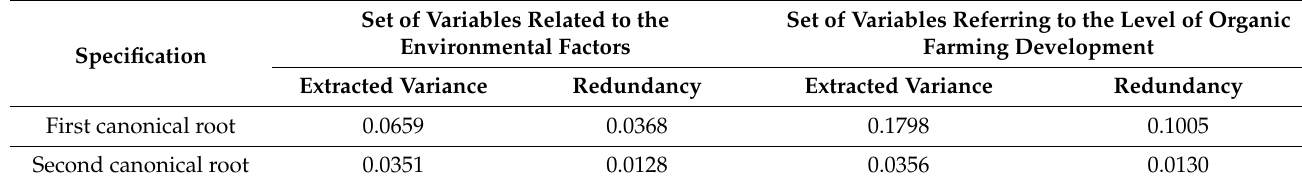
Table 6. Separate variances and